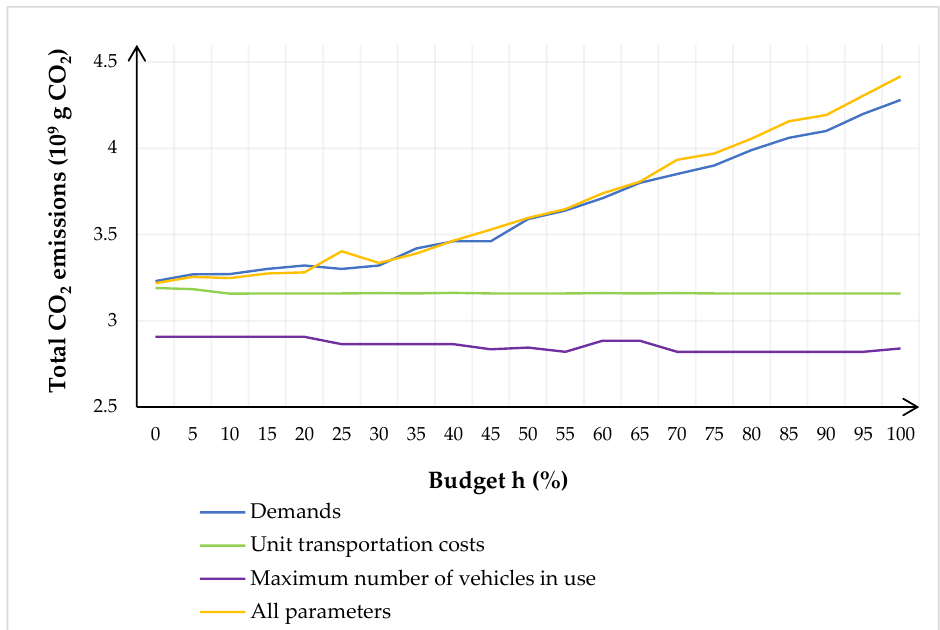
Figure 6. Impacts of the uncertainty budget on the CO 2 total emissions (10 9 g CO 2 ).